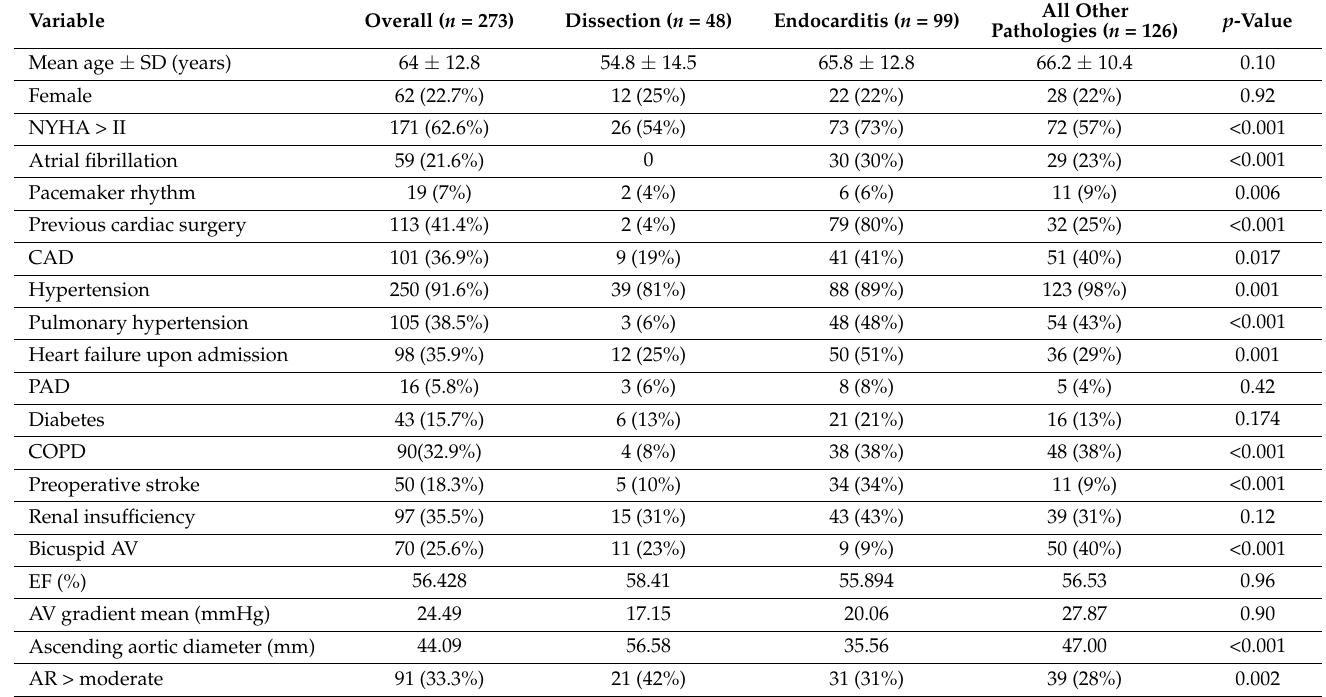
Table 1. Baseline characteristics of the overall patient cohort divided according to the three main pathologies.